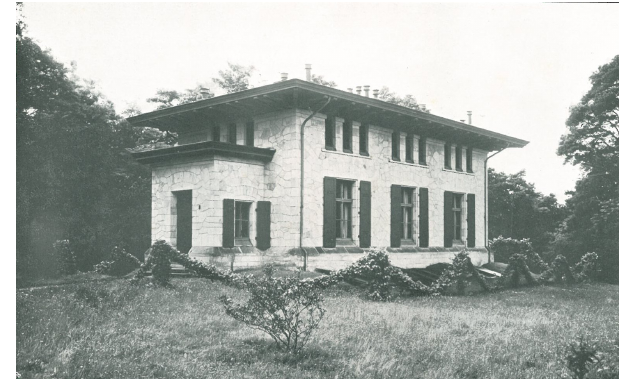
Figure 1. View of the observatory building from the north-east. Source: Hellmann